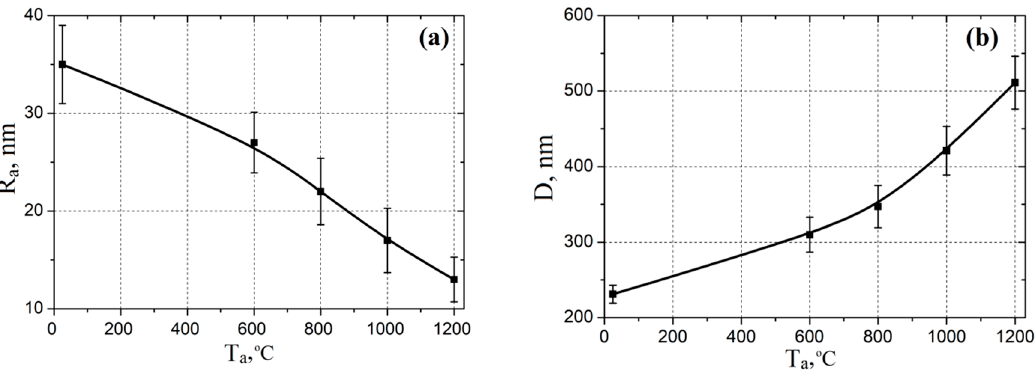
Figure 2. Experimental investigation of annealing temperature effect on the surface roughness ( a ) and grain’s diameter ( b ).